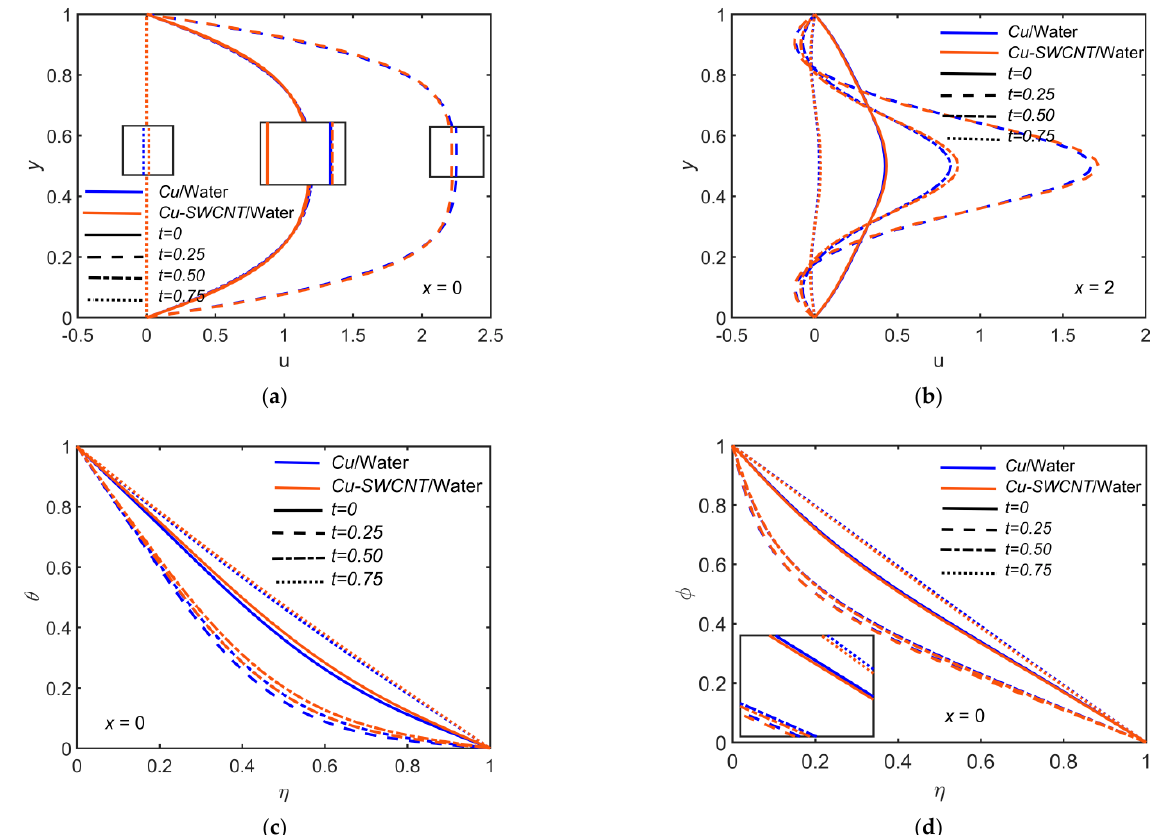
Figure 8. ( a ) 𝑢 profile at 𝑥 = 0 , ( b ) 𝑢 profile at 𝑥 = 2 , ( c ) 𝜃 profile at 𝑥 = 0 , and ( d ) 𝜑 profile at 𝑥 = 0 for distinct val- Figure 8. ( a ) u profile at x = 0, ( b ) u profile at x = 2, ( c ) θ profile at x = 0, and ( d ) ϕ profile at x = 0 for distinct values of t ues of 𝑡 .